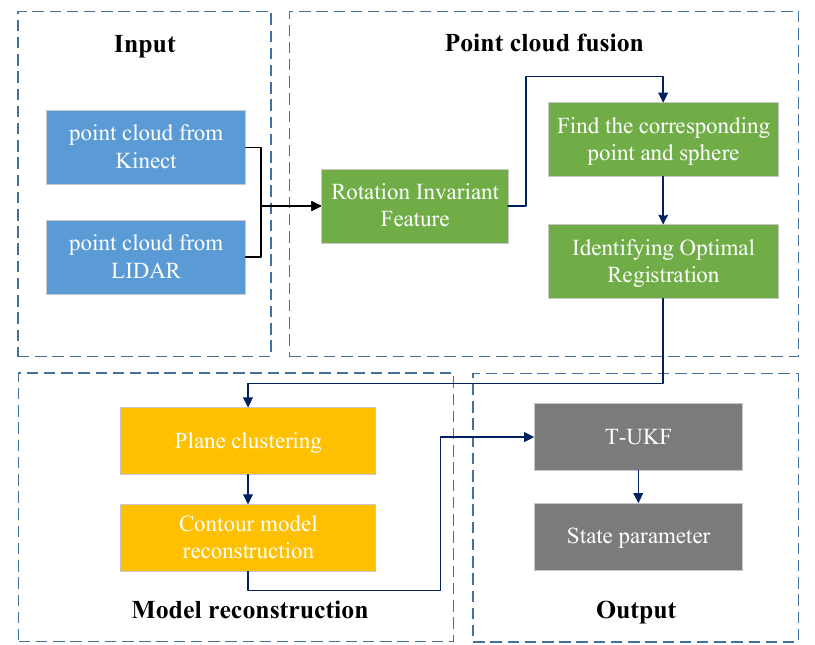
Figure 3. Algorithm structure.